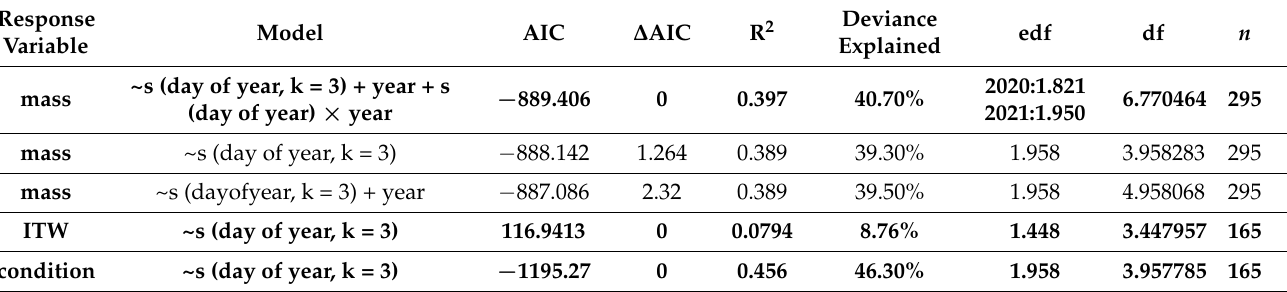
Table 1. GAM outputs and AIC values from analyzing mass, ITW, and body condition with emergence timing. Aside from the initial model for each response variable, we limited smoothers to 3 knots to better explain the biological relevance and fit smoothers with a cubic regression to prevent overfitting. Best fit models are in